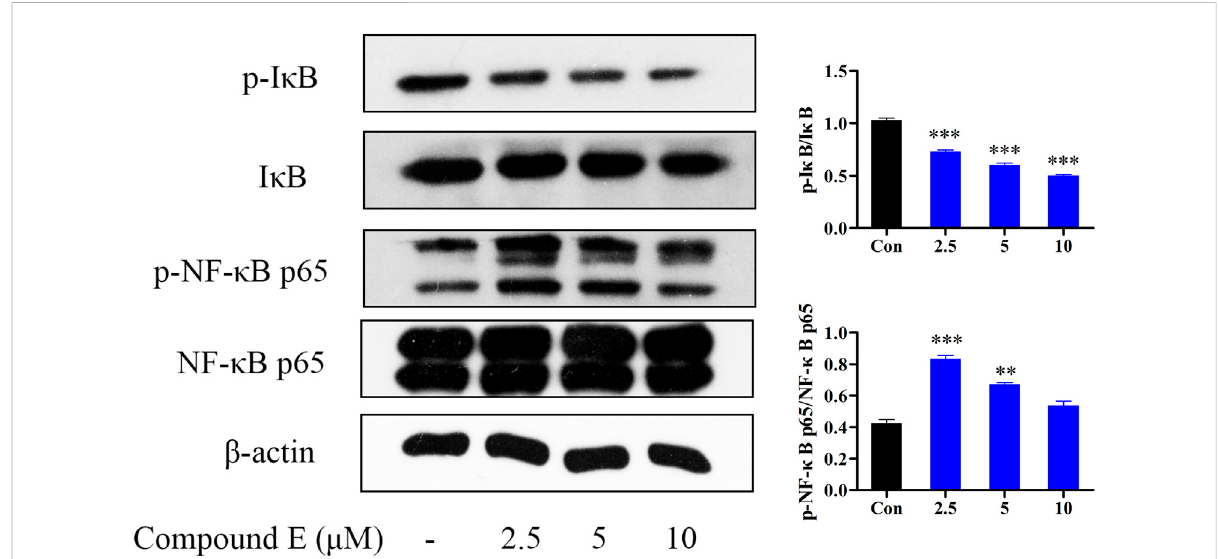
FIGURE 8 Effect of compound E on NF- κ B signaling pathway in HCT116 cells. Cells were pretreated with the various concentrations of compound E (2.5, 5and10 μ M)for24 h.Theexpressionofphospho-NF- κ Bp65,NF- κ Bp65,phospho-I κ B,I κ BwereanalyzedbyWesternblot.*** p < 0.001,** p < 0.01, * p < 0.05 vs. control group. The error bars represent the mean ± SD for three independent experiments.